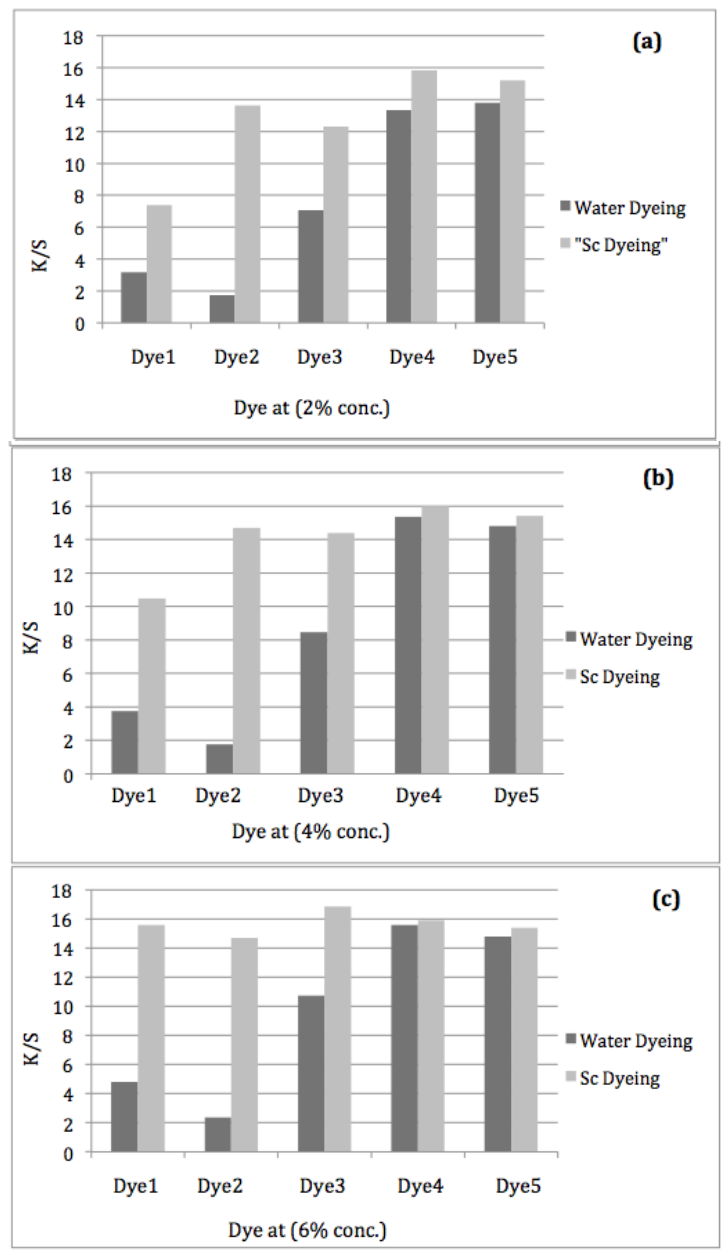
Figure 5. Comparison of color strength of scCO ( b ) at 4% dye conc; ( c ) at 6% dye